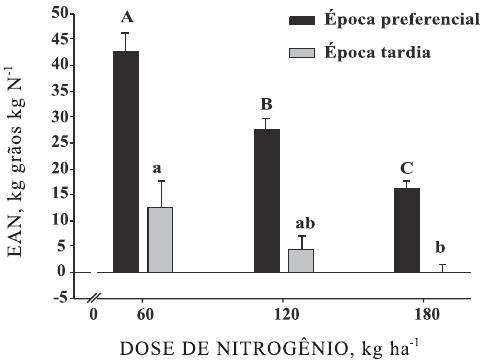
Figura 5. Eficiência agronômica do nitrogênio (EAN) aplicado em cobertura para épocas de semeadura preferencial (novembro) e tardia (dezembro), em função da dose de nitrogênio aplicada em cobertura, na média de quatro densidades de semeadura. Letras maiúsculas representam comparação de médias na época de semeadura preferencial e minúsculas na época de semeadura tardia. Barras verticais representam o